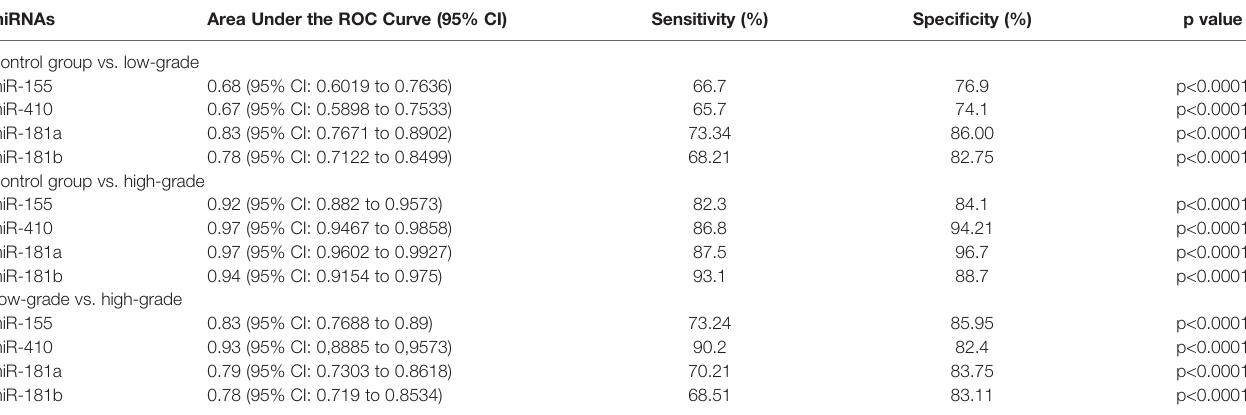
TABLE 3 | Receiver Operating Characteristic (ROC) curves for diagnostic value of circulating miR-181a/b, miR-410 and miR-155 for glioma patients in before surgery time.